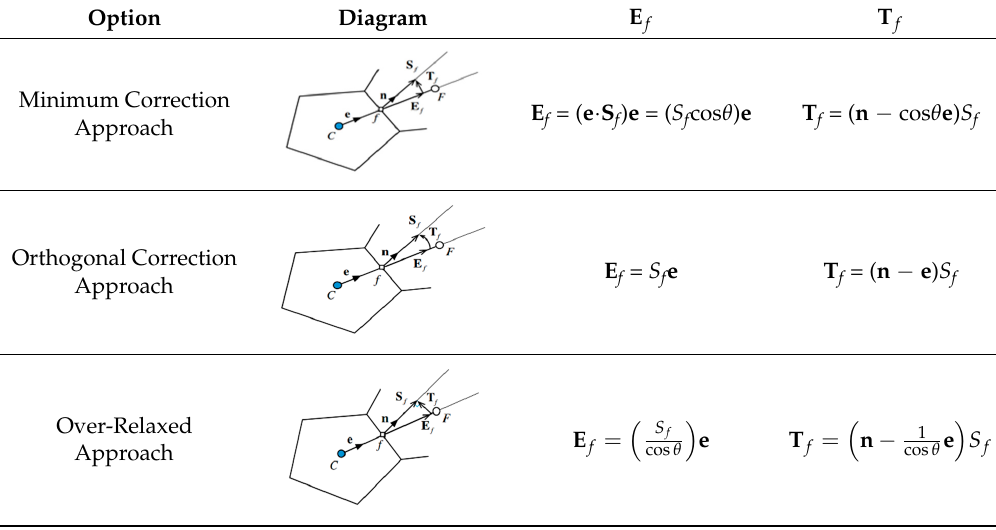
Table 2. Basic data of a multi-section fractured horizontal well in a single-porosity gas reservoir [27]. Parameter